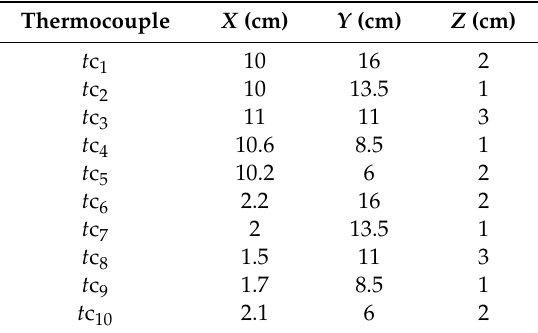
Table 1. Locations of the thermocouples.